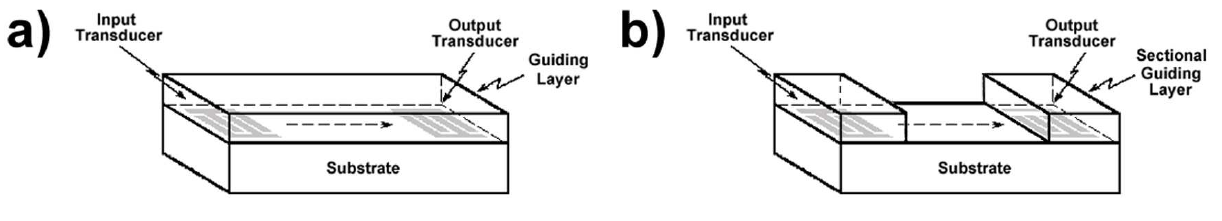
Figure 1. Schematic of a) Love wave devices and b) those having sectional guiding